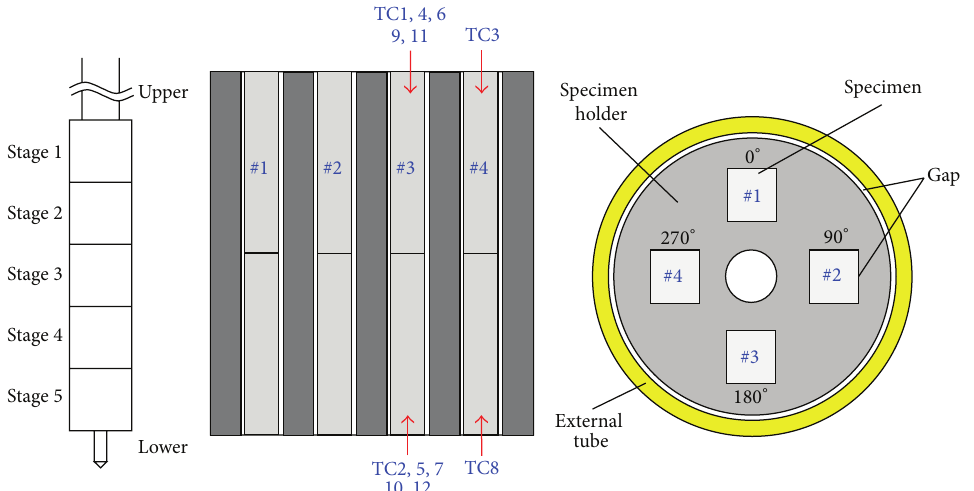
Figure 2: Schematic view of the standard capsule.